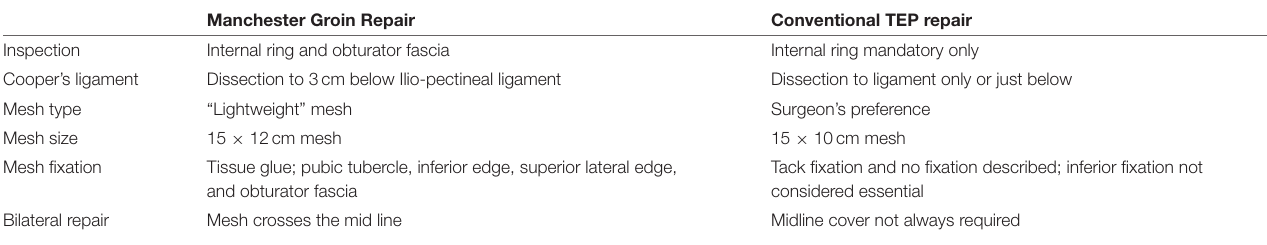
TABLE 1 | Table of comparison; Elements of Manchester Groin Repair c.f. Conventional TEP repair.